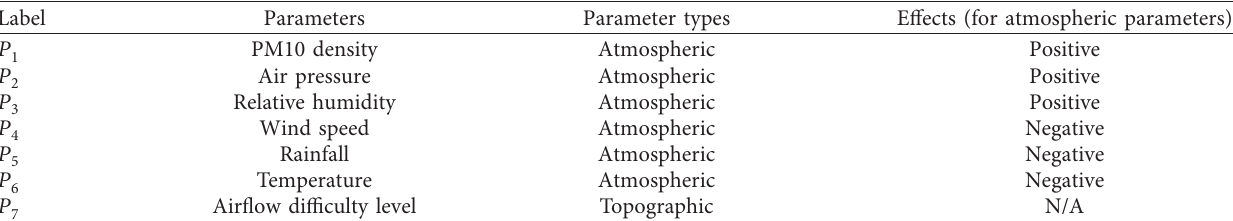
Table 8: Parameter information summary of the haze pollution problem.